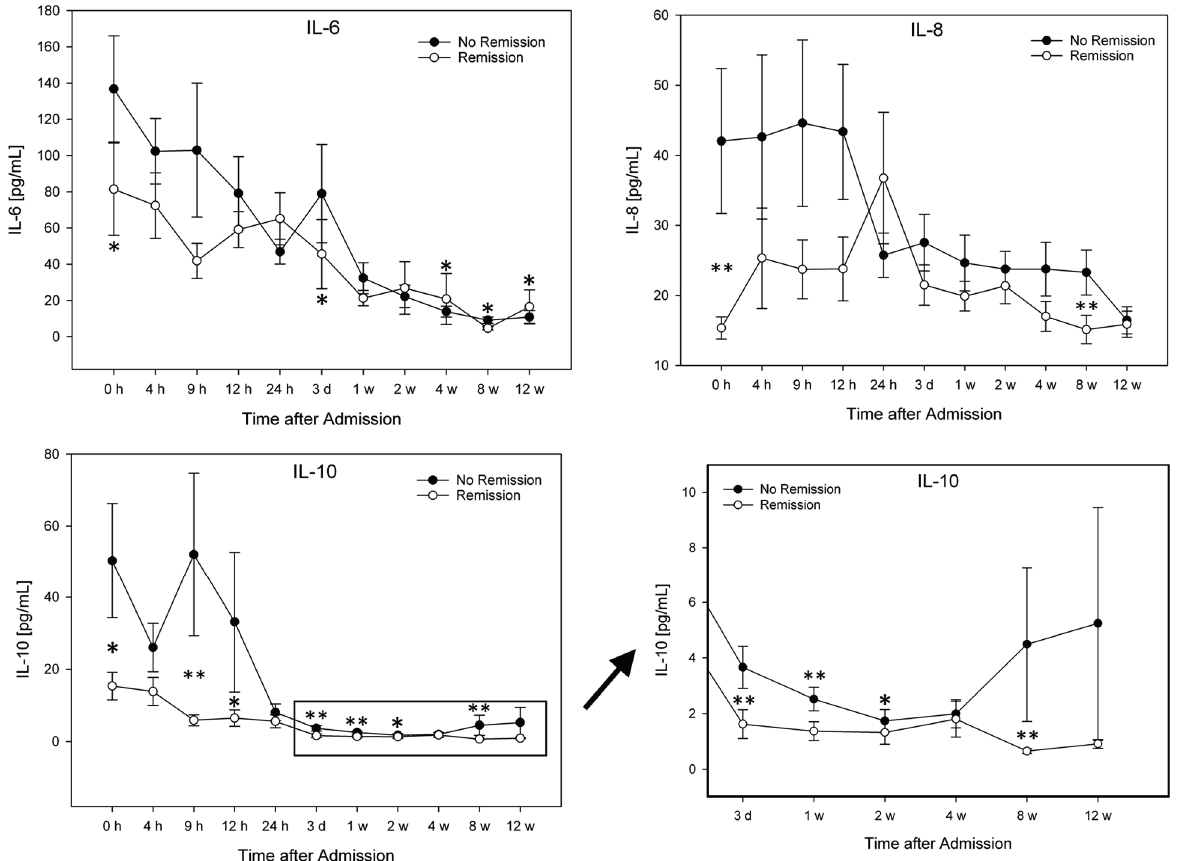
Figure 2. Serum level comparison of all patients with and without neurological remission (AIS improvement after 12 weeks). The Mann-Whitney-U-Test assessed significant differences between both groups at each particular time point, * p < 0.05, ** p < 0.01. Abbreviations: h = hours; d = day; w = week.